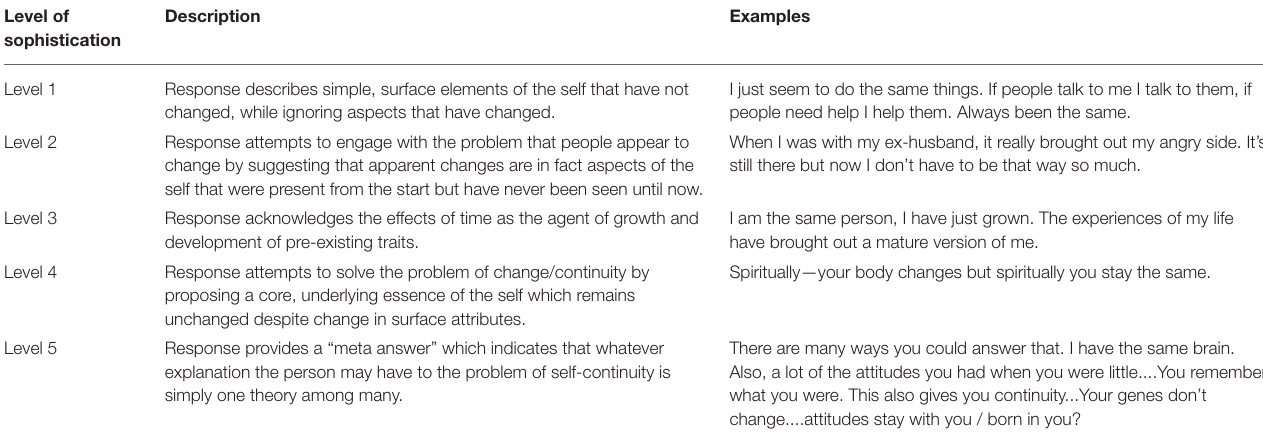
TABLE 3 | Summary of coding scheme used to score on the persistence explanation question of the self-persistence interview. Level of Description sophistication